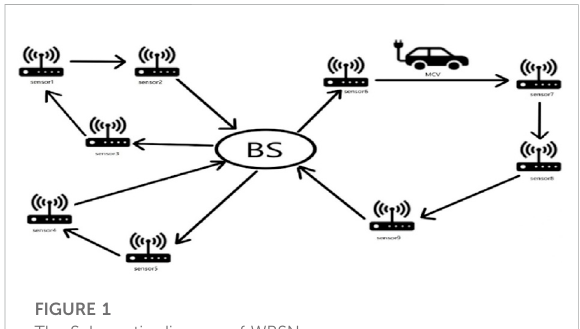
FIGURE 1 The Schematic diagram of